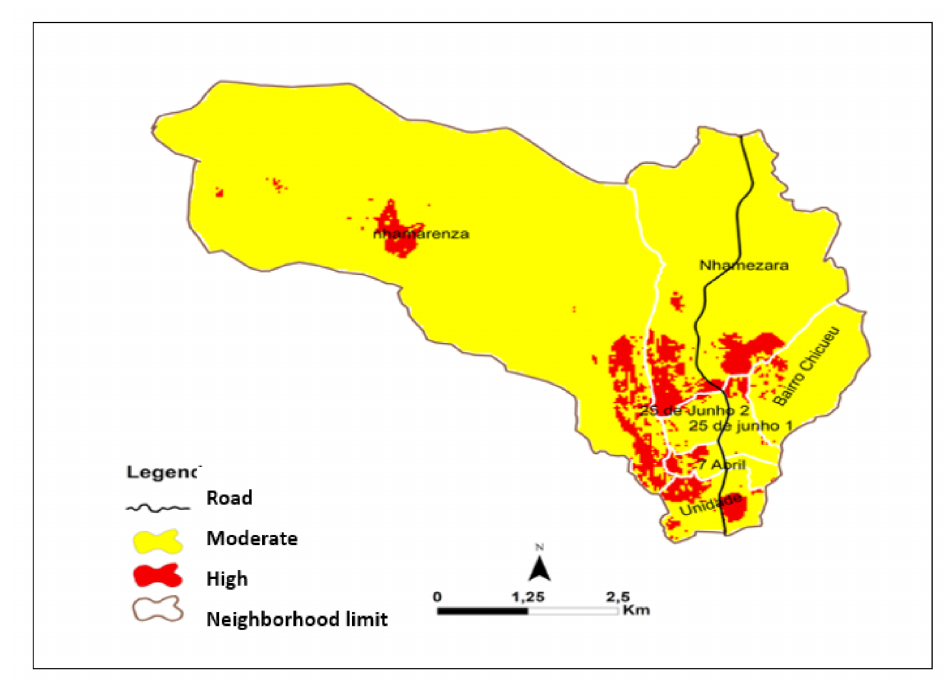
Figure 10. Malaria risk map for Sussundenga Village. Table 4 represents the area under different malaria risk in Sussundenga village.